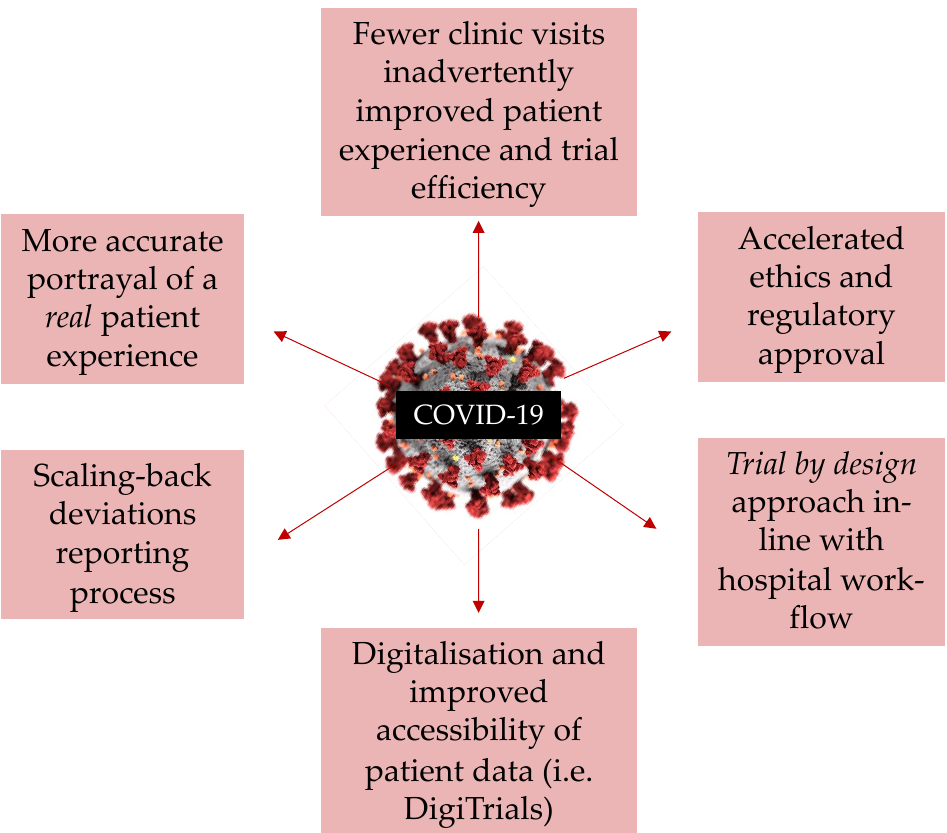
Figure 2. Potential positive impacts on oncology clinical trials due to